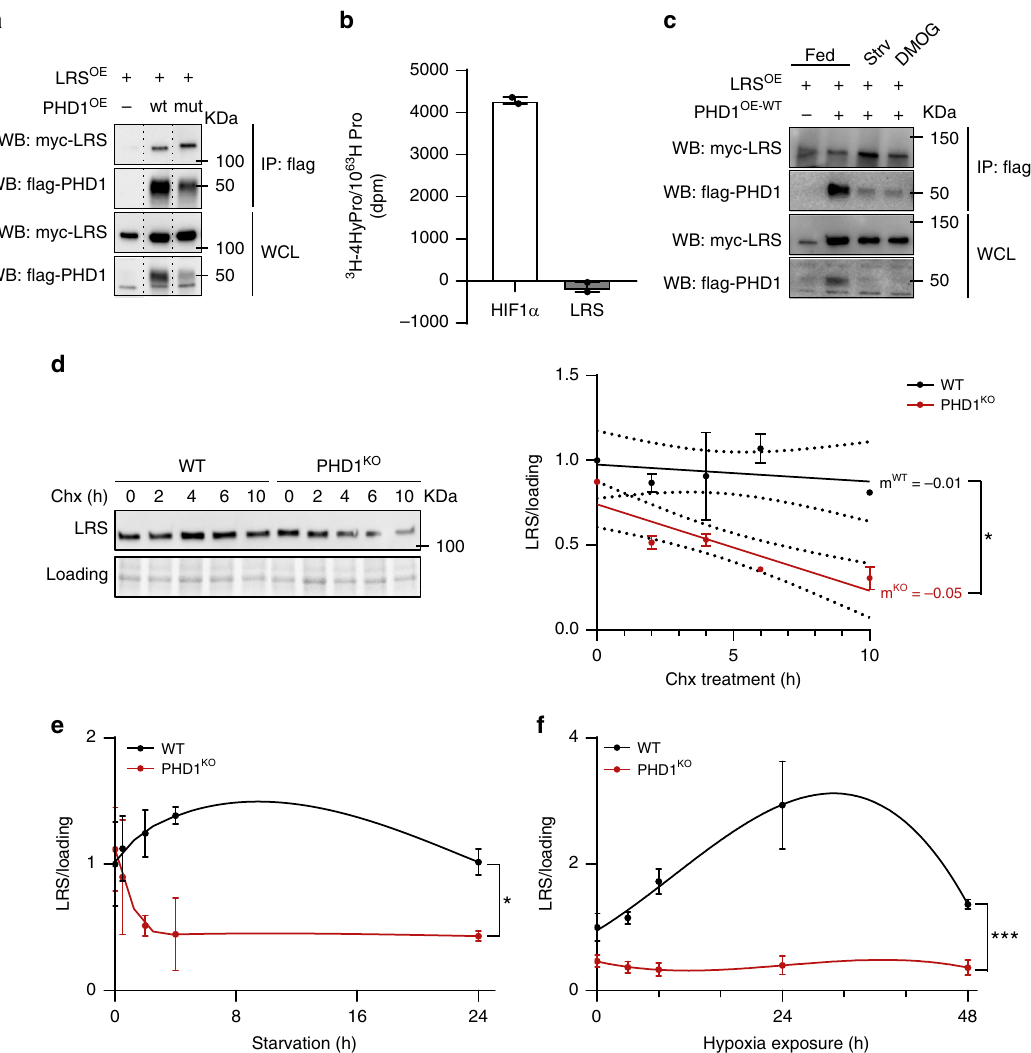
Fig. 5 PHD1 interacts with LRS and controls LRS stability. a HEK293T cells were transfected with myc-LRS, myc-LRS and fl ag-PHD1 WT or myc-LRS and fl ag-PHD1 MUT . Cell lysates were immunoprecipitated with anti- fl ag antibody. Co-precipitation of myc-LRS was determined by western blot analysis using an anti-myc antibody. The fi gure shows a representative experiment. b In vitro hydroxylation assay using 3 H-labeled in vitro translated LRS (gray bar) or HIF1 α (white bar; positive control) in the presence of af fi nity puri fi ed PHD1. c HEK293T cells were transfected with myc-LRS or myc-LRS and fl ag-PHD1 WT and treated with DMOG or amino acid starved for 4 h. Cell lysates were immunoprecipitated with anti- fl ag antibody. Co-precipitation of myc-LRS was determined by western blot analysis using an anti-myc antibody. The fi gure shows a representative experiment. d Representative picture (left panel) and quanti fi cation (right panel) of western blot analysis of LRS protein levels in WT (black line) and PHD1 KO (red line) myotubes exposed to cycloheximide (Chx) for different amounts of time. Dots represent the mean from 2 independent experiments. e Time-course analysis of LRS protein levels in WT (black line) and PHD1 KO (red line) myotubes exposed to amino acid starvation. Dots represent the mean from three independent experiments. f Time-course analysis of LRS protein levels in WT (black line) and PHD1 KO (red line) myotubes exposed to hypoxia (1% oxygen). Dots represent the mean from 3 independent experiments. Statistics: two-way ANOVA (in e and f , interaction effects are indicated) with a a t test ( d ) (* p < 0.05; ** p < 0.01; *** p < 0.001; ns not signi fi cant). Bar graphs and line graphs represent mean ± SEM (error bars). Data are presented as fold change to WT 0 h ( d , e , f ). See also Supplementary Fig. 5. Source data are provided as a Source Data fi